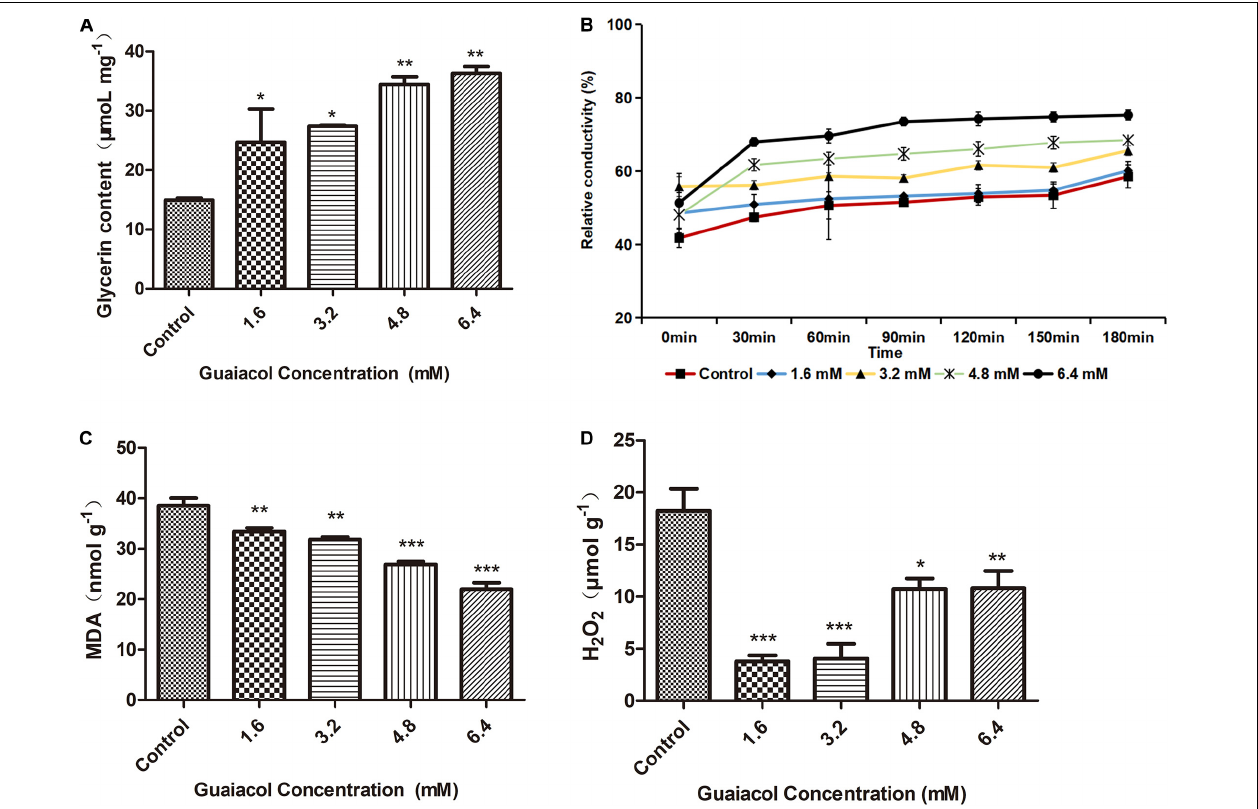
FIGURE 3 | Effect of guaiacol on (A) glycerin content, (B) the relative conductivity, (C) MDA content, and (D) H 2 O 2 content of the mycelia of F. graminearum (PH-1). Mycelia treated with guaiacol at 0, 1.6, 3.2, 4.8, and 6.4 mM for 24 h were harvested for the measurements. Each treatment has three replicates, * p < 0.05, ** p < 0.01, and *** p < 0.001.